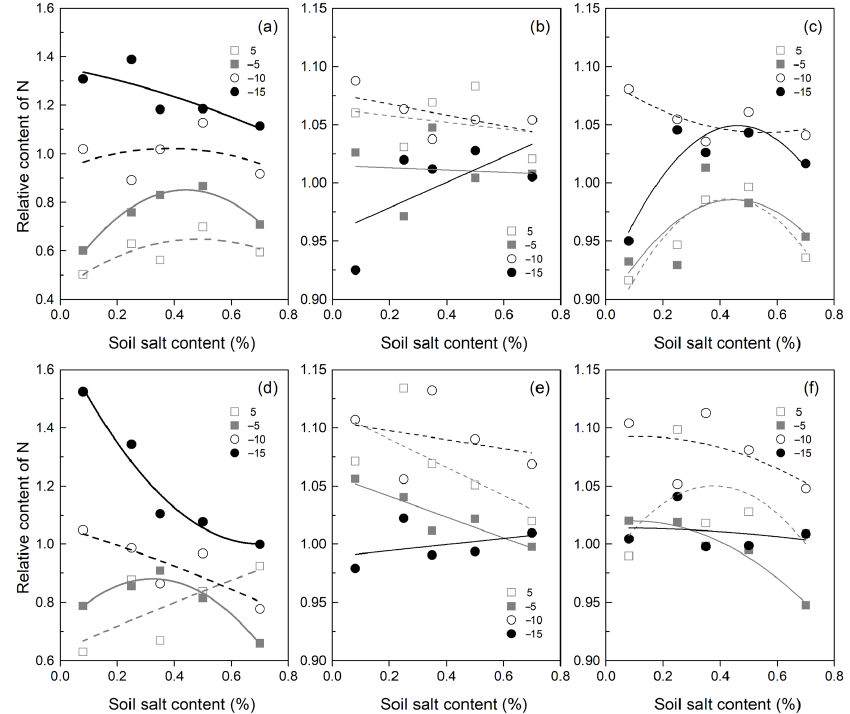
Figure 3. Ratio of the time-weighted mean soil NH 4+ -N (( a ): 40% water holding capacity (WHC); ( d ): 80% WHC), NO 3 − -N (( b ): 40% WHC; ( e ): 80% WHC), and soil inorganic nitrogen (SIN) ( c ): 40% WHC; ( f ): 80% WHC) contents to their initial values before freezing–thawing incubation. The variation ranges and coefficients of variation of relative NH 4+ -N, NO 3 − -N, and SIN contents induced by freezing temperature, salinity, and moisture are shown in Figure 4. Variations in relative NH 4+ -N, NO 3 − -N, and SIN contents induced by freezing tempera-